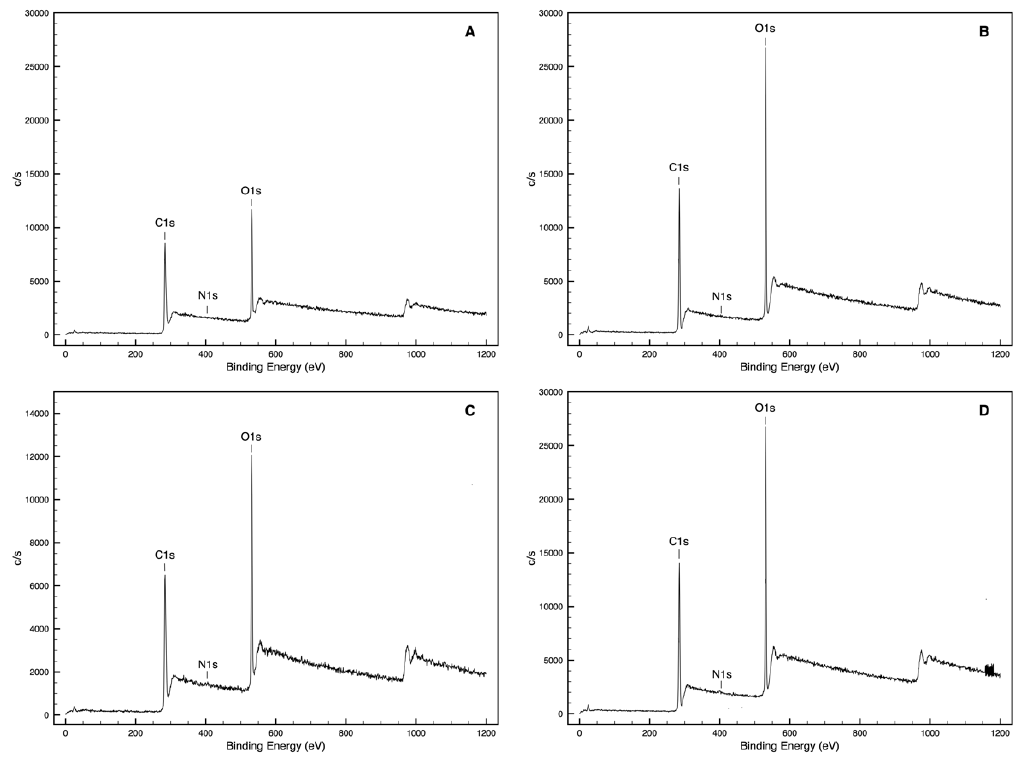
Figure A3. XPS survey scan of cellulose / polyester nonwoven wipe (W2), ( A ) W2R, ( B ) W2RQ, ( C ) W2P, ( D )